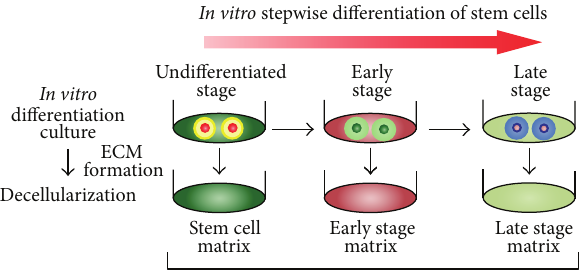
Figure 2: The concept and preparation procedure of stepwise tissue development-mimicking